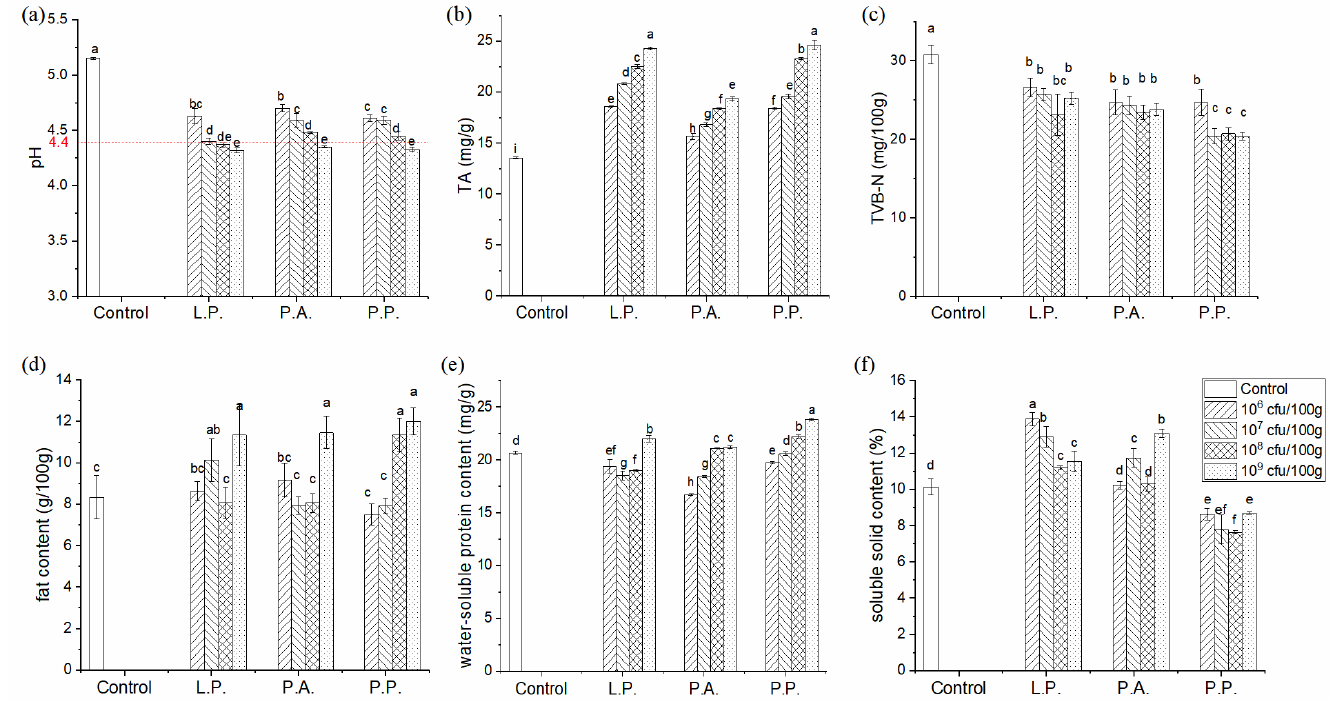
Figure 3. The pH values ( a ), TA contents ( b ), TVB-N contents ( c ), crude fat contents ( d ), water-soluble protein contents ( e ), and soluble solid contents ( f ) of Zhayu products prepared by spontaneous fermentation (control) and fermented with L. plantarum (L.P.), P. acidilactici (P.A.), and P. pentosaceus (P.P.) at different inoculation amounts. Different letters on the bar denote significant differences ( p < 0.05).